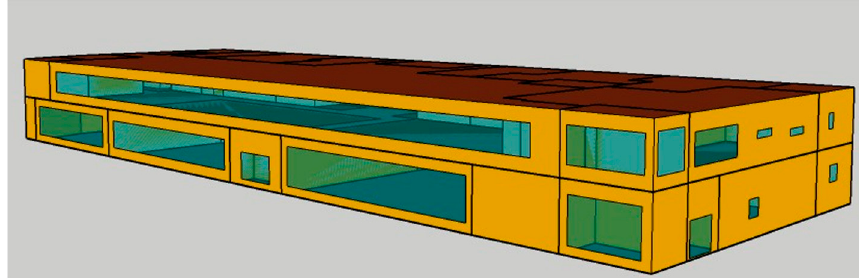
Figure 5. Architectural model in SketchUp.